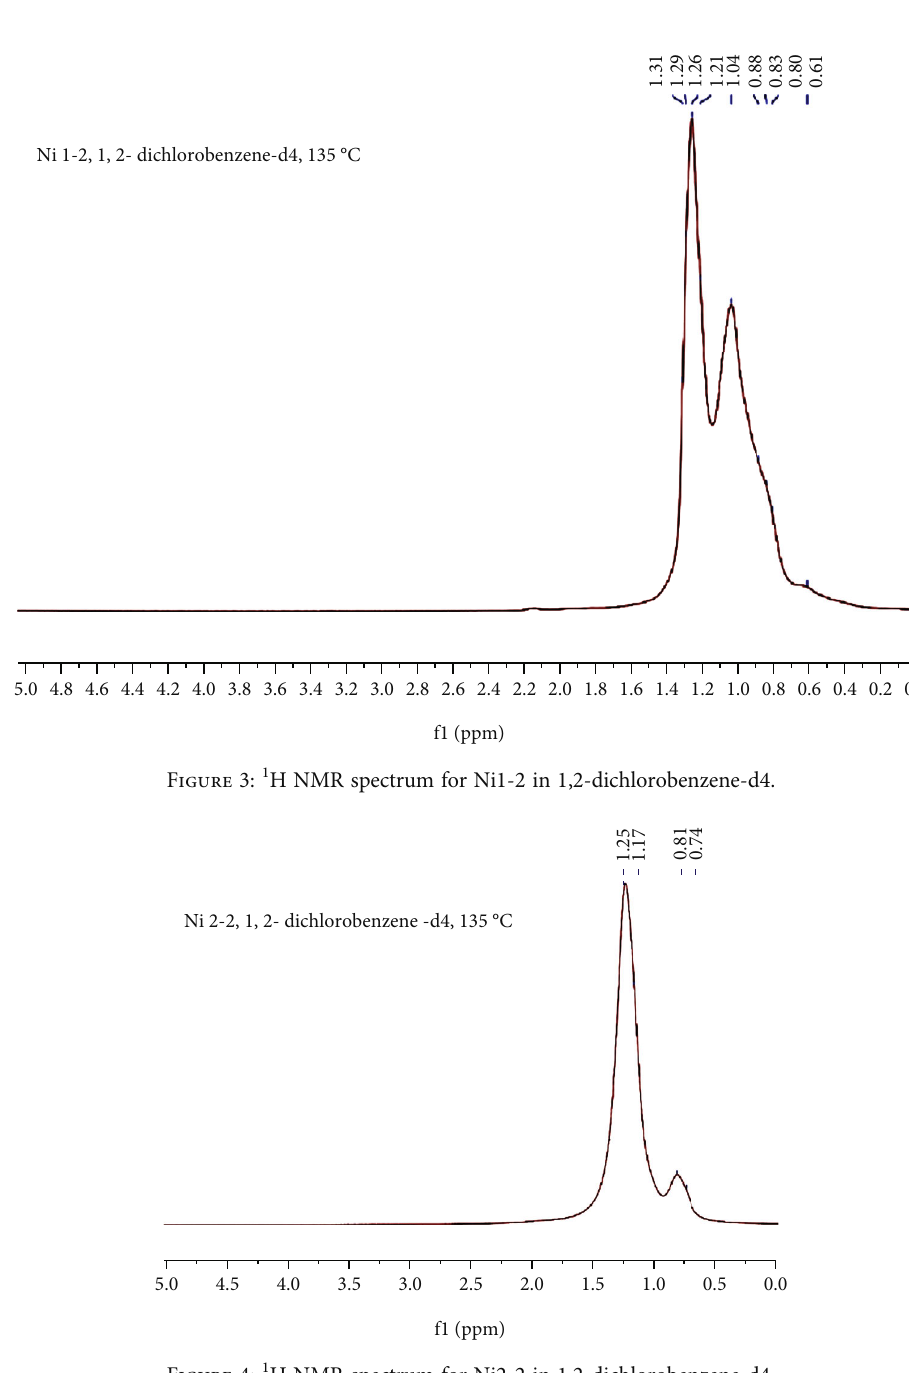
Figure 4: 1 H NMR spectrum for Ni2-2 in